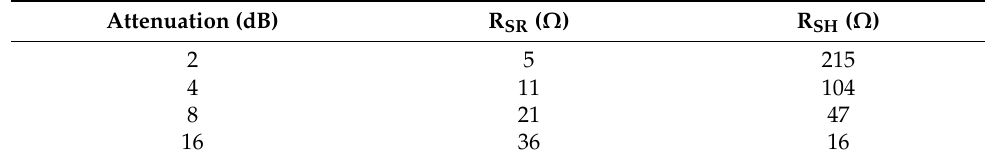
Table 1. Component values of T-type resistive attenuators.